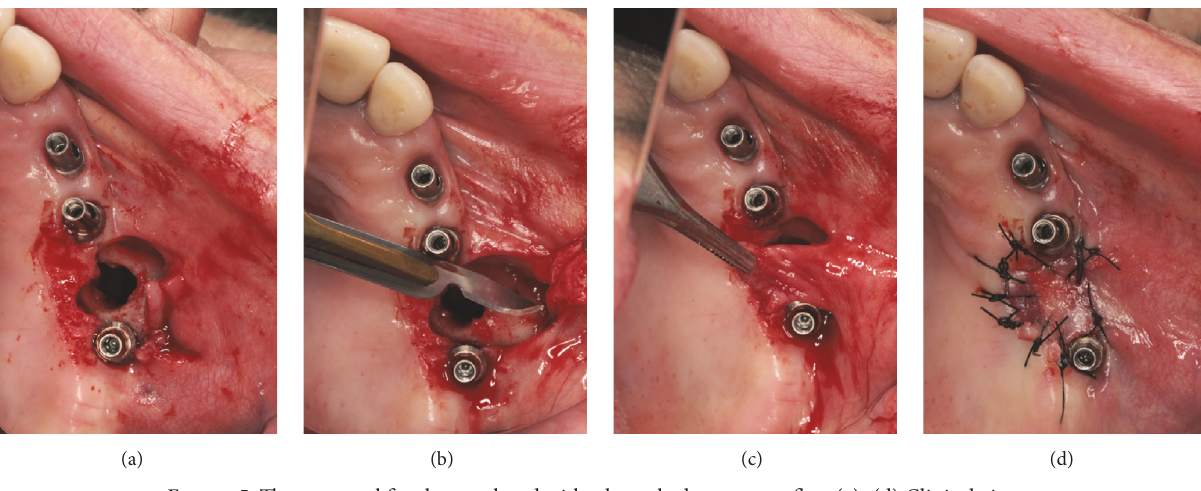
Figure 5: The oroantral fistula was closed with a buccal advancement flap. (a)–(d) Clinical views.